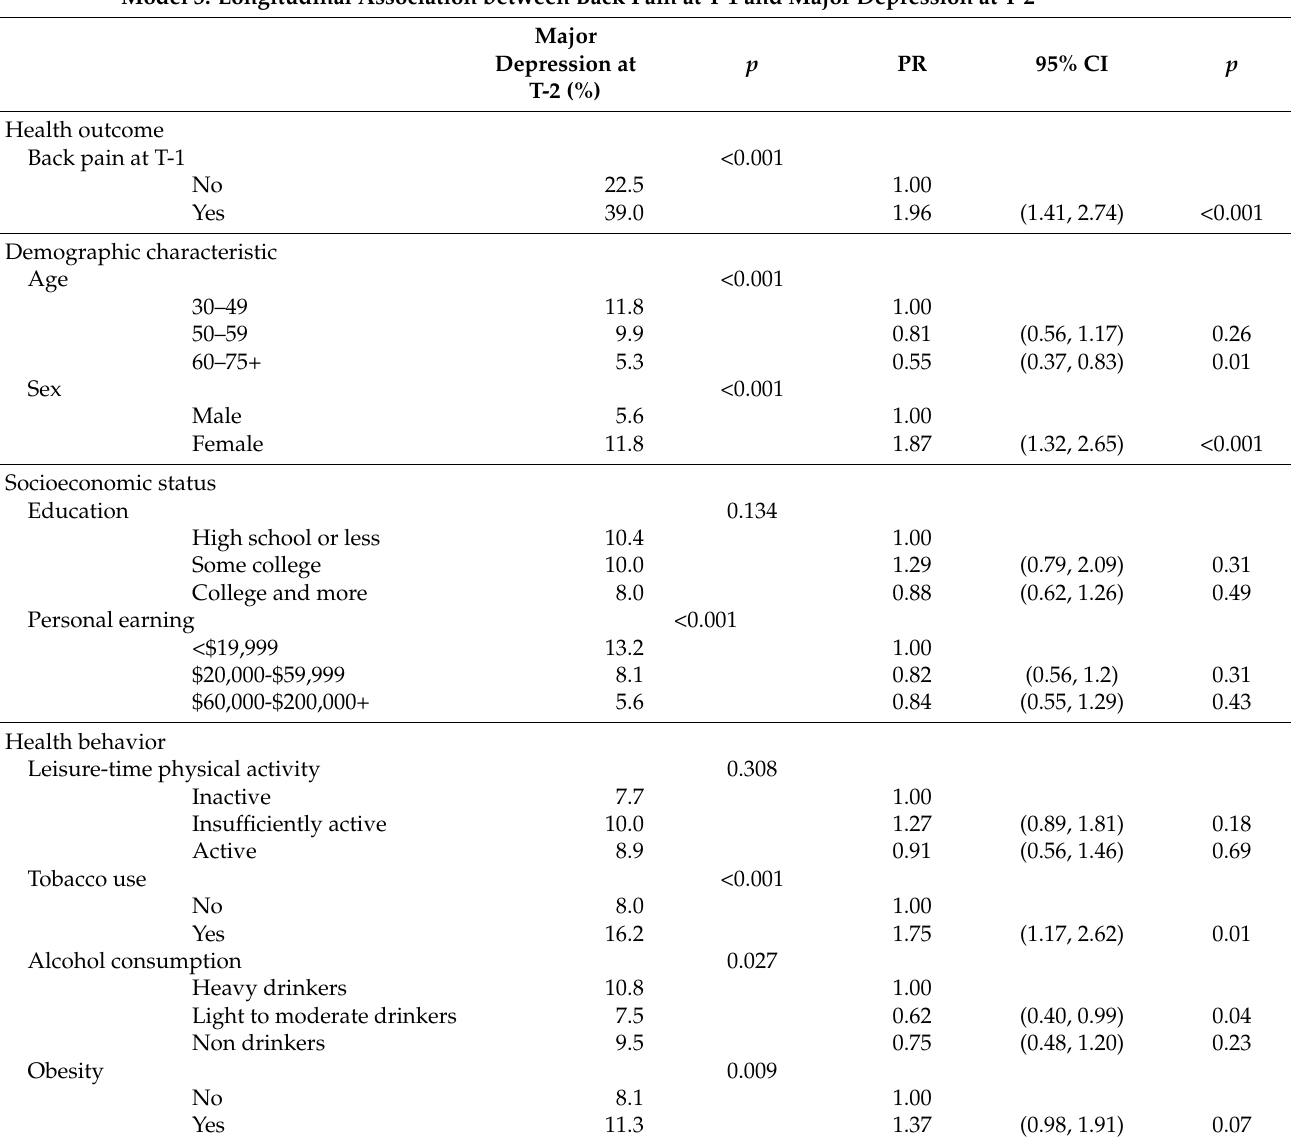
Table 3. Prevalence of major depression at T-2 and longitudinal association between back pain at T-1 and major depression at